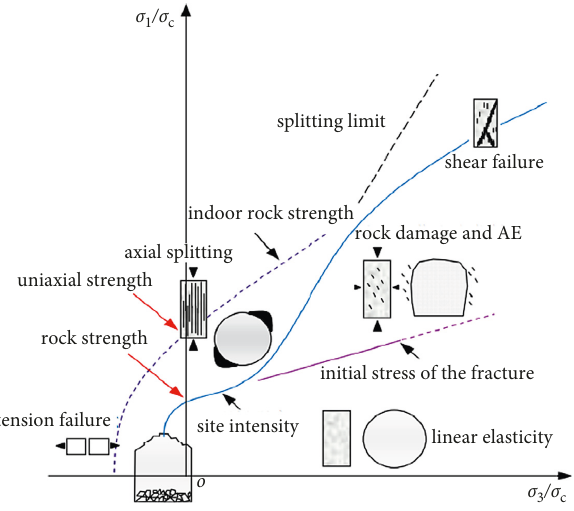
Figure 2: Failure of surrounding rock with different principal stress ratios [15].